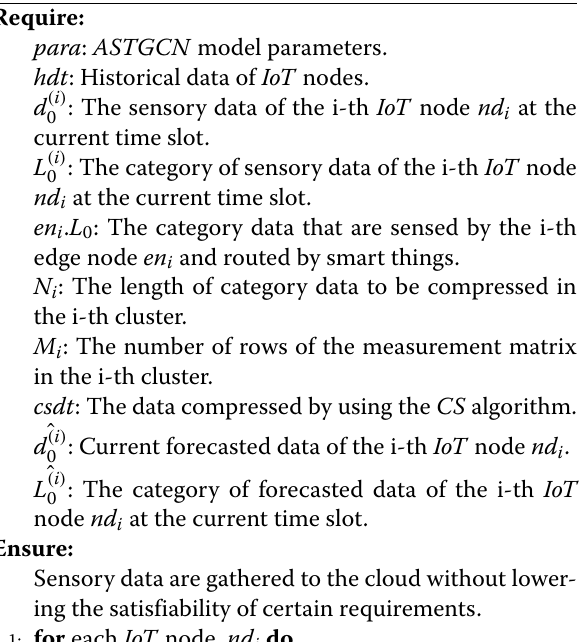
Algorithm 1 Sensory Data